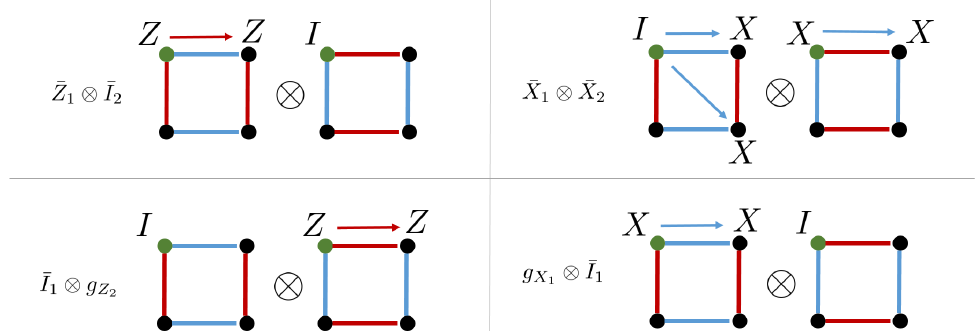
Figure 50. We assume, without loss of generality, there is a single site input in the double-copy tensor in the top left corner (green) and will find the equivalent operator to the right column up to a